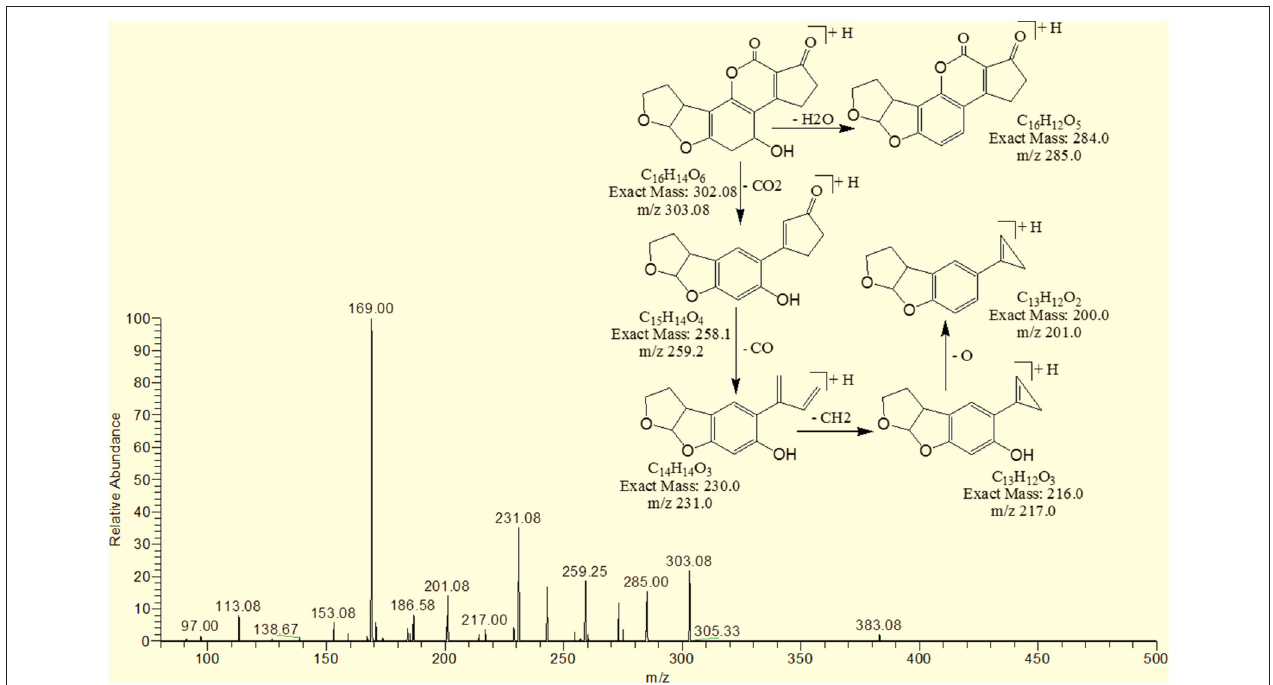
FIGURE 5 | MS/MS spectra and fragmentation pathway of degradation product with